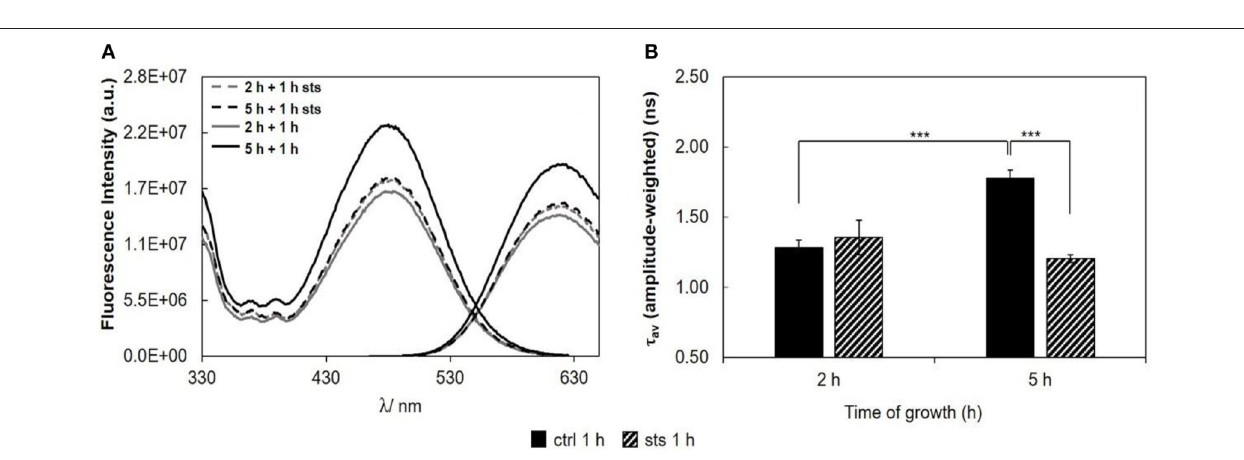
Frontiers in Physiology |